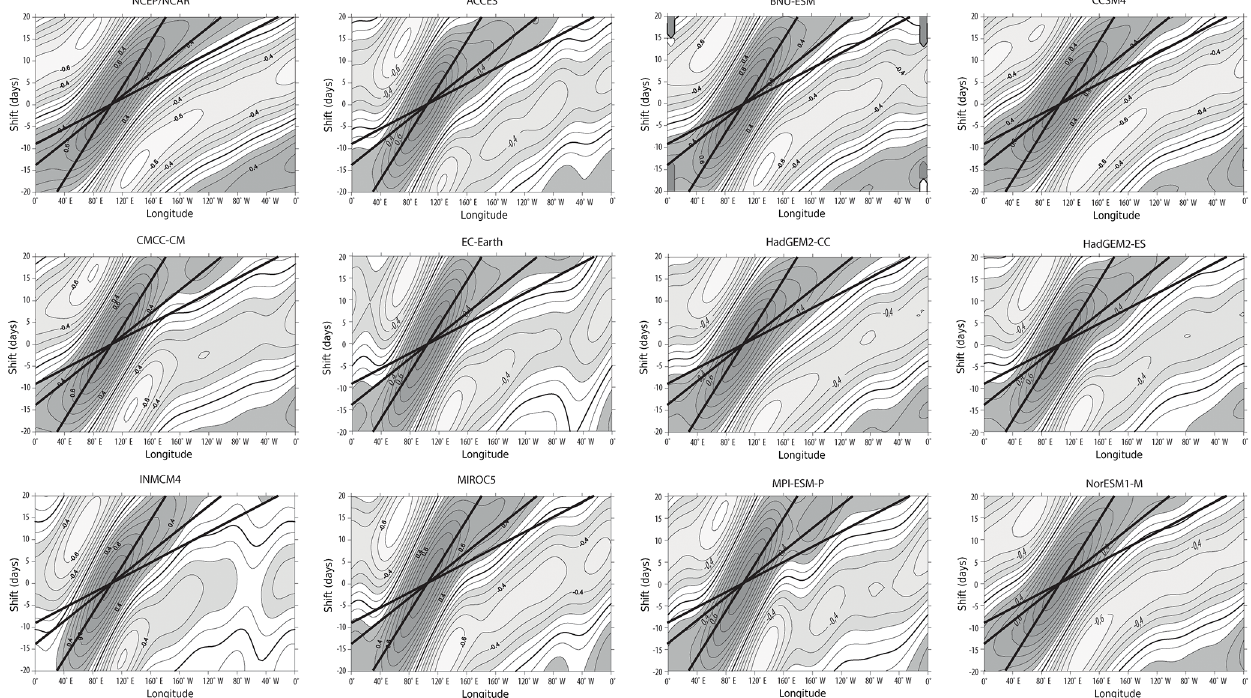
Figure 7. Lag correlation of the MJO filtered U850 averaged along the Equator between 5 ◦ N and 5 ◦ S with respect to itself at the Equator and 105 ◦ E for the NCEP/NCAR Reanalysis and the CMIP5 models. The three diagonal lines correspond to phase speeds of 5, 10 and 15ms − 1 .